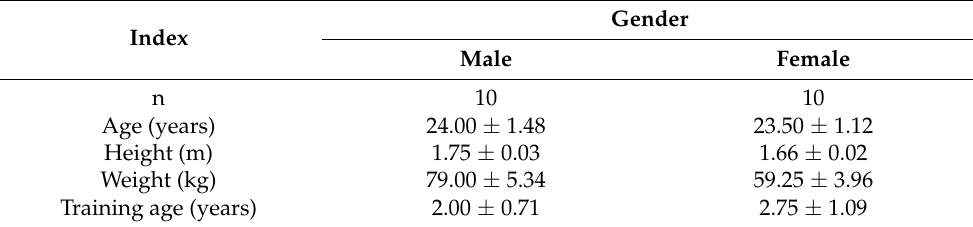
Table 1. Basic information of